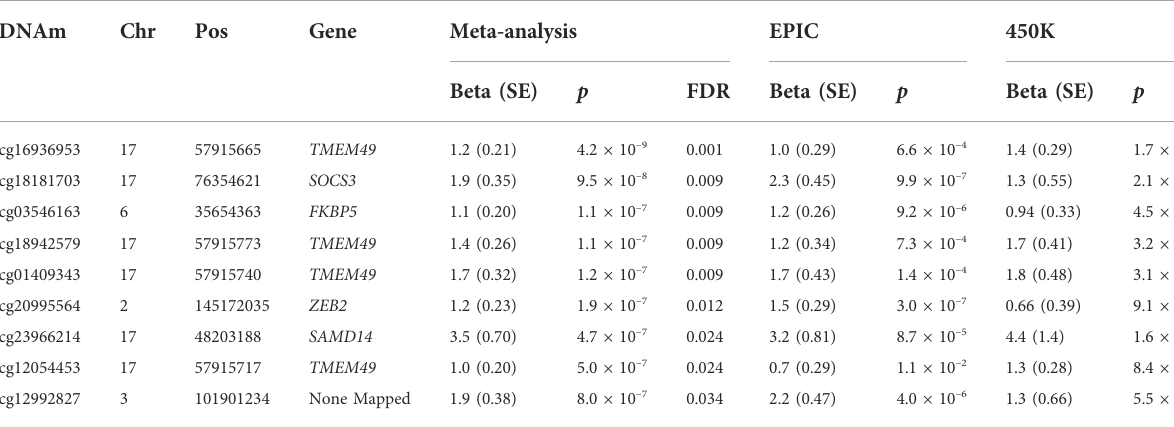
TABLE 3 DNAm sites are signi fi cantly associated with selected liver markers after meta-analysis and FDR correction. Serum albumin